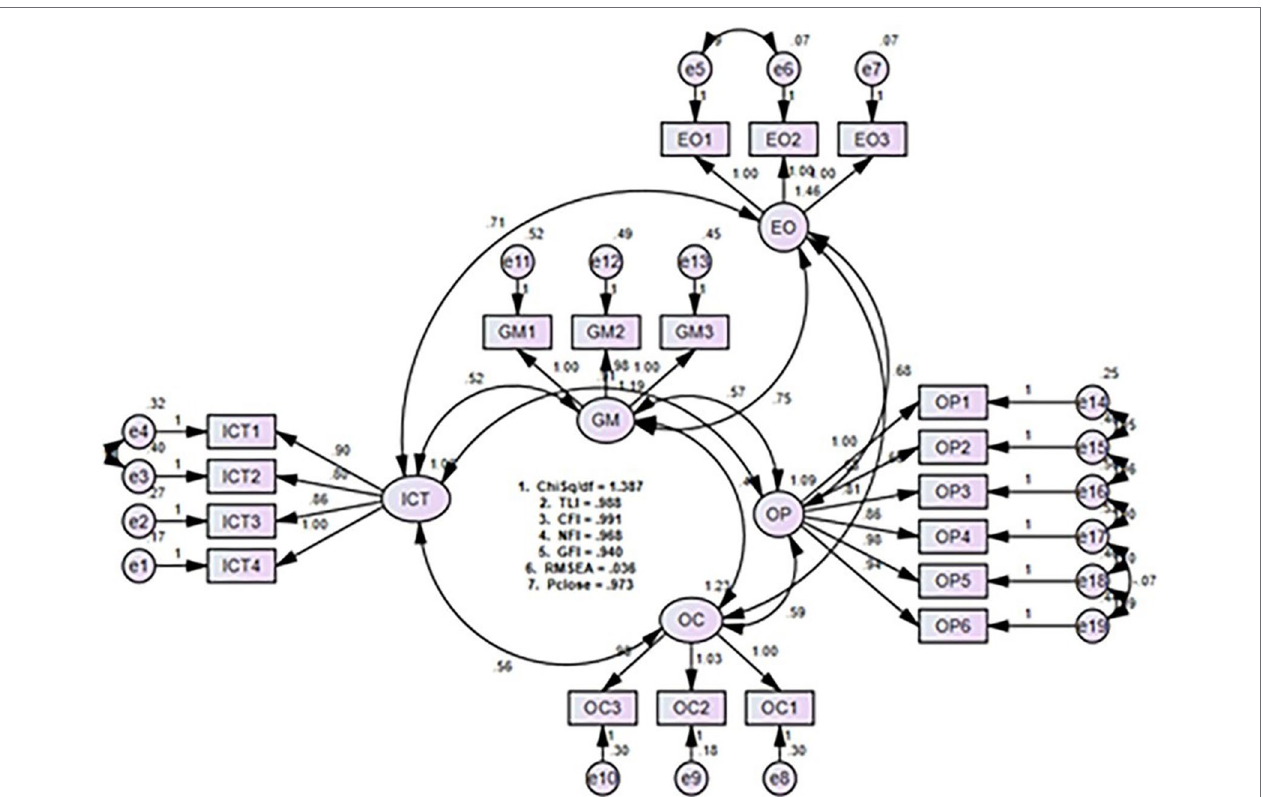
FIGURE 2 | Confirmatory factor analysis.